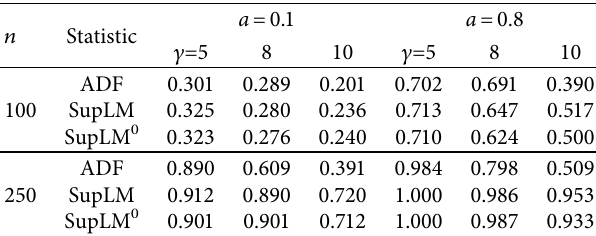
Table 1: Size of SupLM tests. Table 2: Power of SupLM and SupLM0 tests and 5% nominal size against two-regime